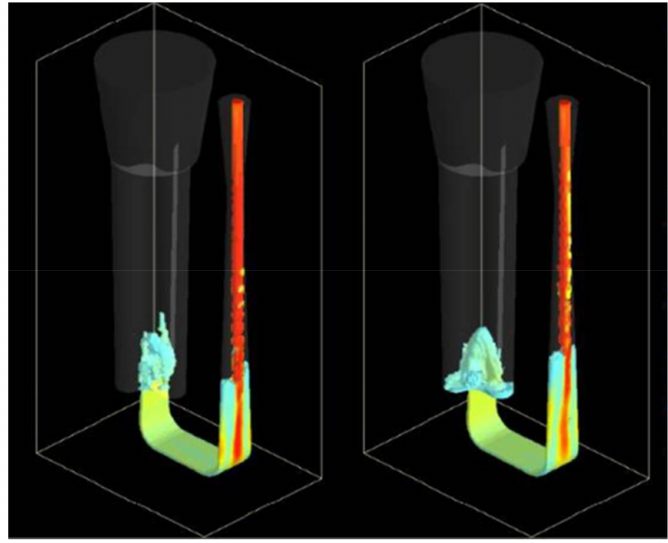
Figure 4. Improper downsprue tapering (NovaFlow &